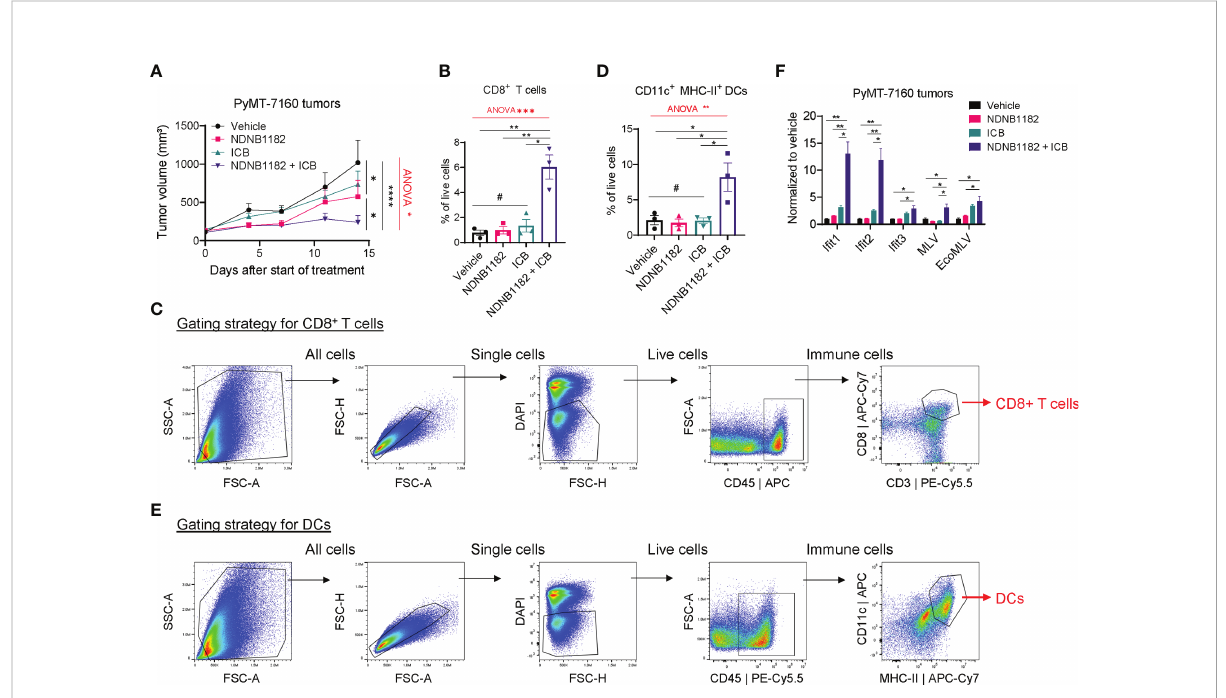
FIGURE 4 NDNB1182 enhanced ICB therapy in the PyMT-7160 syngeneic mammary tumor model. (A) Growth curves of PyMT-7160 tumors treated with vehicle control (N=8), NDNB1182 (50mg/kg, i.p. daily; N=10), ICB (anti-PD1 plus anti-CTLA4, 10mg/kg, i.p., twice/week; N=10), or concurrent NDNB1182 plus ICB (N=8). (B, C) Quanti fi cation results and gating strategy for tumor-in fi ltrating CD8 + T cells in treated PyMT-7160 tumors. (D, E) Quanti fi cation results and gating strategy for tumor-in fi ltrating CD11c + MHC-II + dendritic cells (DCs) in treated PyMT-7160 tumors. (F) qRT-PCR result of I fi t1/2/3 and two ERV elements for PyMT-7160 tumors treated with DMSO, NDNB1182, ICB, or NDNB1182 plus ICB (N=3/ group).In (A, B, D, F) , data represent mean ± SEM. #P>0.05; *P<0.05, **P<0.01, ****P<0.0001, Student ’ s t-test. In (A, B, D) , one-way ANOVA test result was shown in red (*P<0.05, **P<0.01,